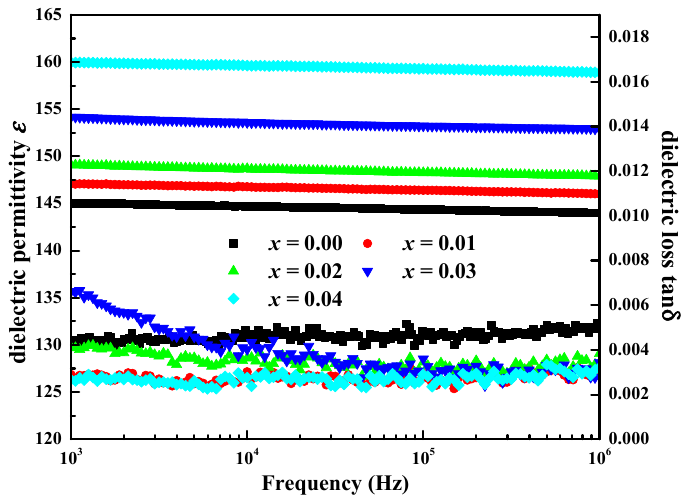
Figure 5. Room temperature dielectric permittivity and dielectric loss tan δ for the Mn/Nb co-doped NBT ceramics as a function of frequency.